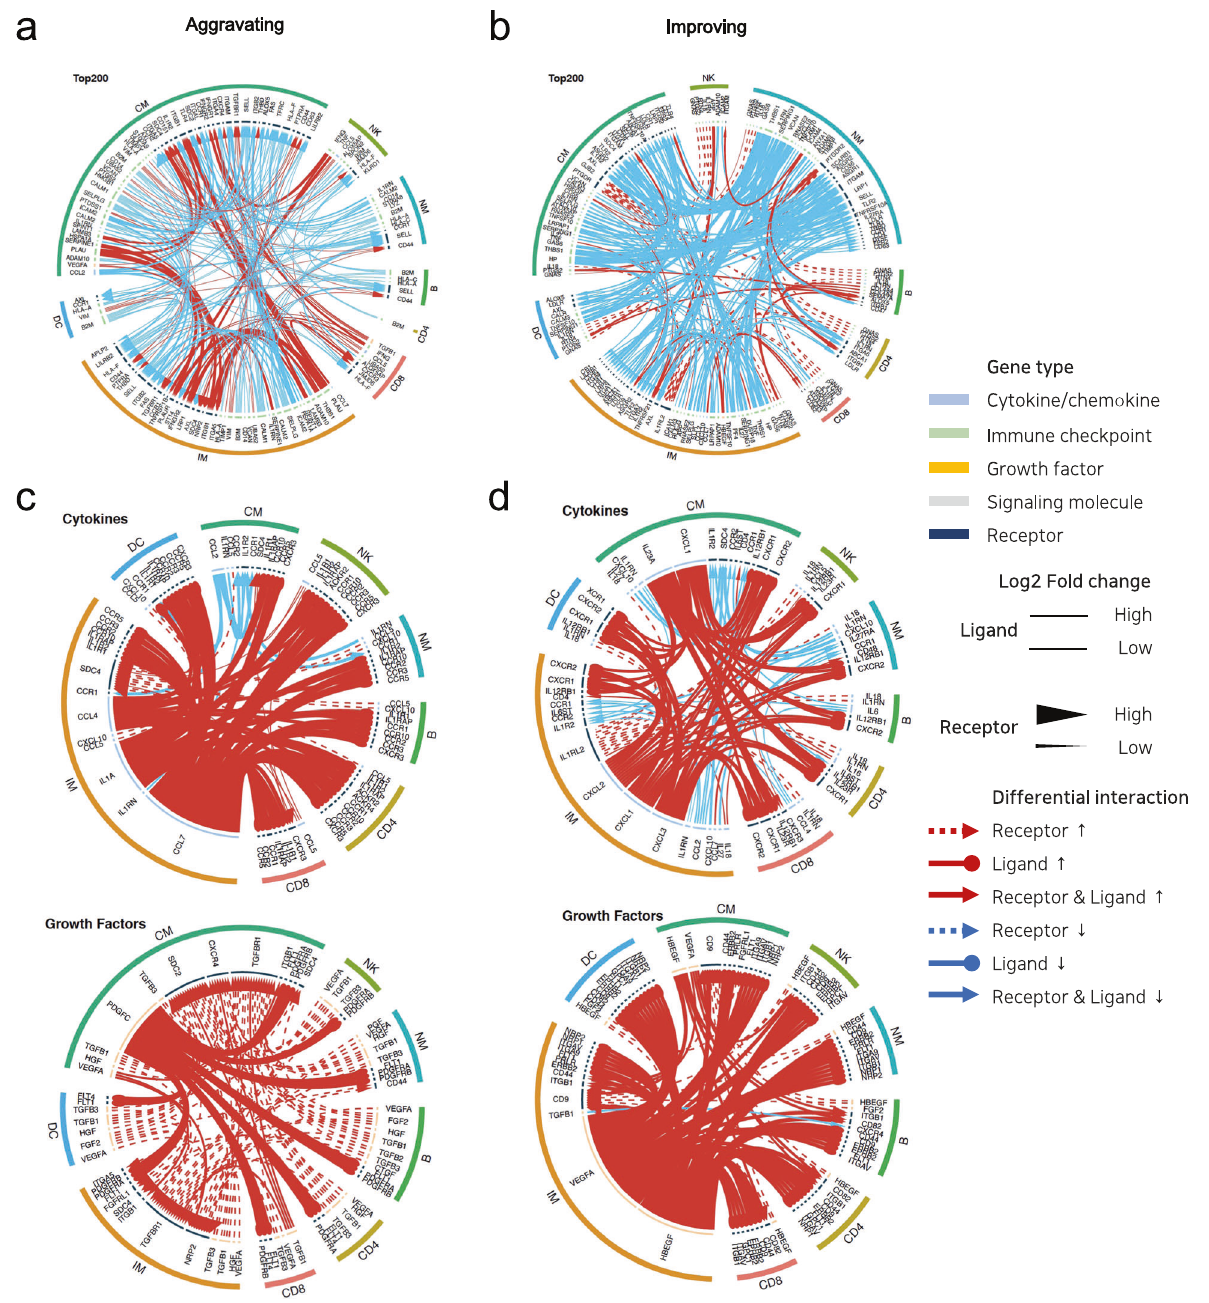
Fig. 2 Crosstalk between immune cells characterizes aggravation and improvement of disease. a , c Interactome analysis of potential interactions between different immune cell types during the aggravation and b , d improvement phases. The widths of lines and arrows represent a relative log2-fold change in ligands and receptors, respectively. Dotted lines with an arrowhead represent differential levels of a receptor; solid lines with a dot represent differential levels of a ligand; solid lines with an arrowhead represent simultaneous differential levels of a ligand and receptor. Red indicates upregulated gene expression; cyan indicates downregulated gene